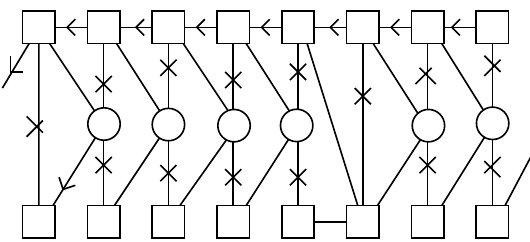
Figure 24 . Tube with (cid:13)ux (0 ; 0 ; : : : ; (cid:0) 1 ; 0 ; : : : ; 0 ; 1 ; : : : ) obtained from closing minimal punctures. The two maximal punctures are of the same color and